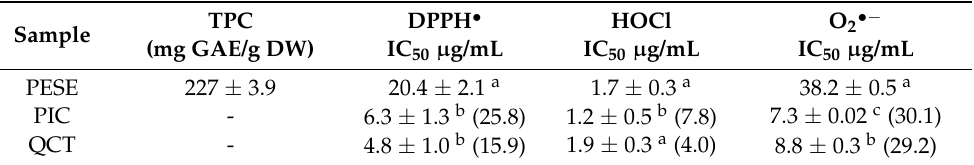
Table 3. Total phenol content (TPC) and antioxidant capacity of ethanolic extract of passion fruit seeds and piceatannol, toward HOCl and O 2 •−